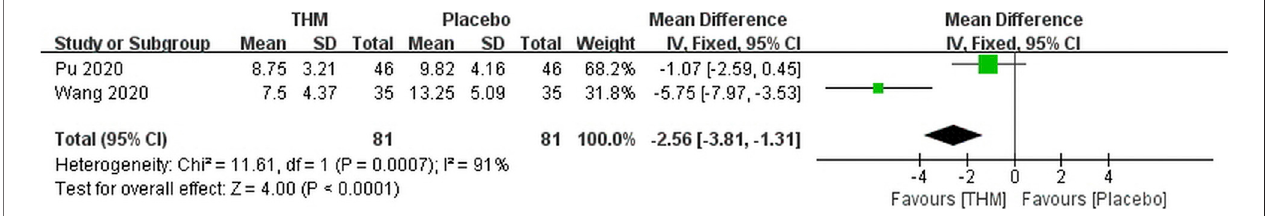
FIGURE 5 | Forest plot of the pittsburgh sleep quality index of THM versus placebo. THM, traditional herbal medicine.